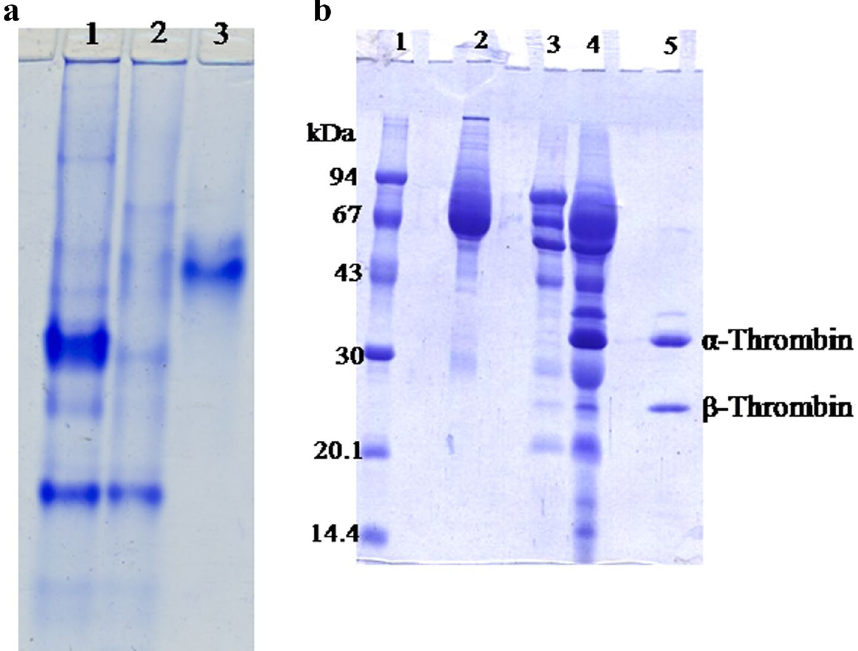
Fig. 2 a Native 7% PAGE for the purification steps of camel thrombin: (1) the prothrombin-containing sample, (2) the activated prothrombin-containing sample, and (3) the purified camel thrombin. b 12% SDS PAGE: (1) molecular weight markers, (2) plasma, (3) 35–70% saturated (NH 4 ) 2 SO 4 fraction enriched with prothrombin, (4) activated prothrombin into thrombin by snake venom, (5) the purified camel